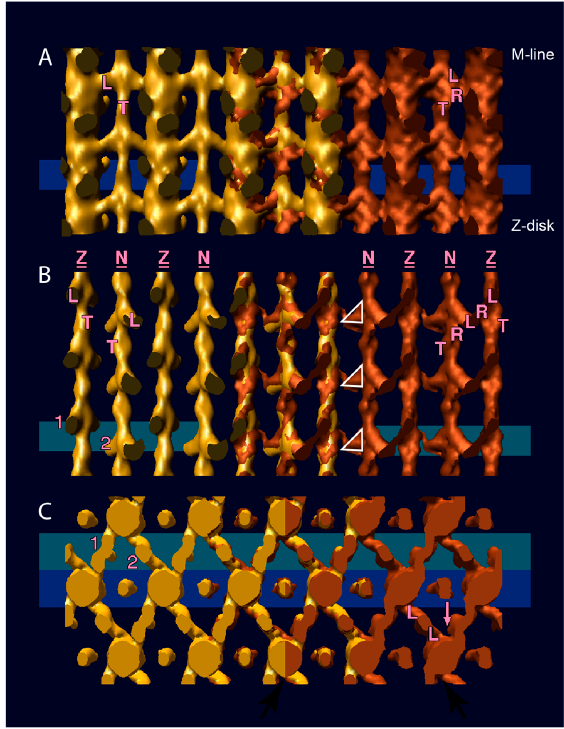
Figure 3. Surface views of oblique section image reconstructions (OSRs) from IHM treated with adenylyl-imidodiphosphate (AMPPNP), a non-hydrolysable analog of ATP at 23 °C (on the left in gold color) and in rigor (on the right in copper color), superposition of rigor and AMPPNP in the middle. ( A ) Myac layers; ( B ) actin layers; ( C ) transverse view of unflared-X layer (AMPPNP on the left) and flared-X layer (rigor on the right). The region in the myac layer of ( A ) and the region of the actin layer of ( B ) contained in the transverse view in ( C ) are marked by the Wedgewood blue and teal green backgrounds respectively. L, Lead bridge; R, rear bridge; T, troponin. Triangles in ( B ) highlight the triangular shape of rigor lead bridges. Lead bridges of rigor and AMPPNP do not coincide exactly in shape so that in the superimposed region in the center, extra mass in rigor shows as copper color. The troponin density is more pronounced in rigor, possibly because the thin filaments are better ordered. In ( B ) the cross-bridge pair that produces the two arms of the unflared-X are labeled 1 and 2. These same cross-bridges are similarly labeled in ( C ). In ( C ) the rigor rear bridge is located at the far surface of the flared-X layer (denoted by the arrow). The extra density provided by the rigor rear bridge results in the close proximity of the vertex arms in projections of flared-X. Reprinted from [28] with permission from